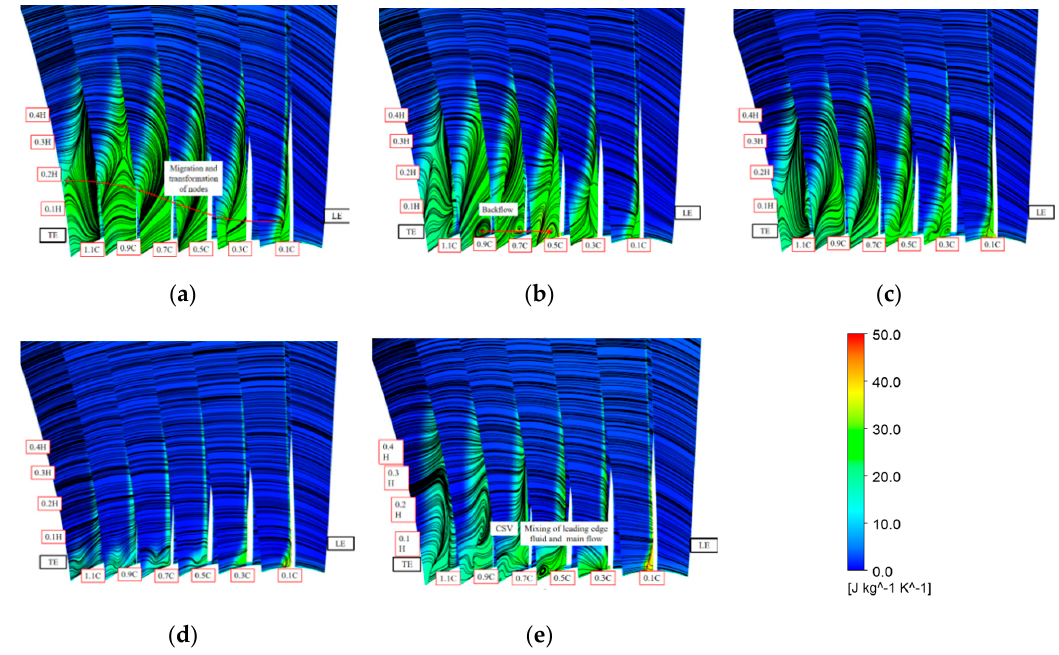
Figure 10. Entropy contour and surface streamlines. ( a ) Ori; ( b ) Case 1; ( c ) Case 2; ( d ) Case 3; ( e ) Case 4.